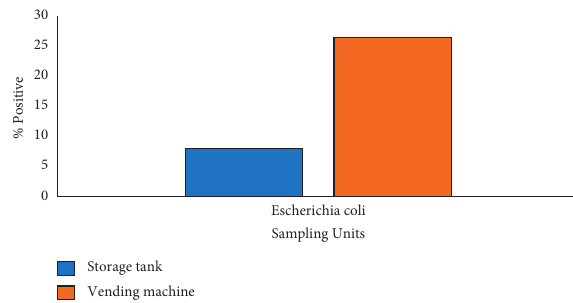
Figure 10: Escherichia coli variation in milk from storage tanks and vending